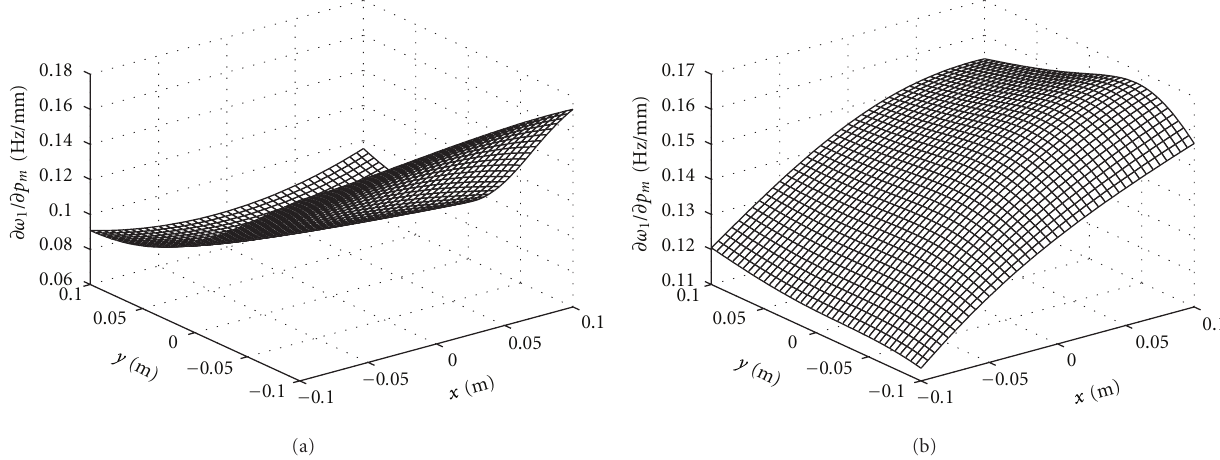
Figure 6: Sensitivities of the first-order natural frequency to the structure parameters. (a) Radius of the struts. (b) Radius of the lead